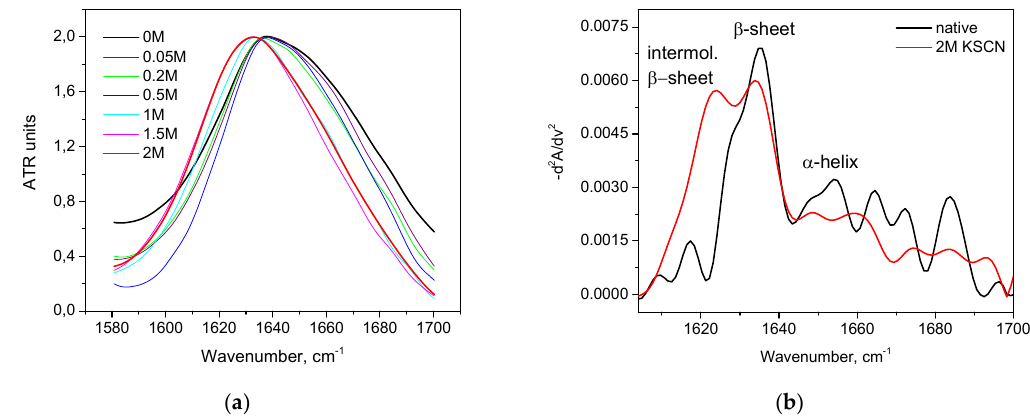
Figure 4. Changes in the character of the Amide I band ( a ) and changes in the second derivative of the Amide I band ( b ) of trypsin in 20% wt. aqueous solution at 23 °C with various concentrations of KSCN. Only the most representative curves are shown for the sake of clearness.